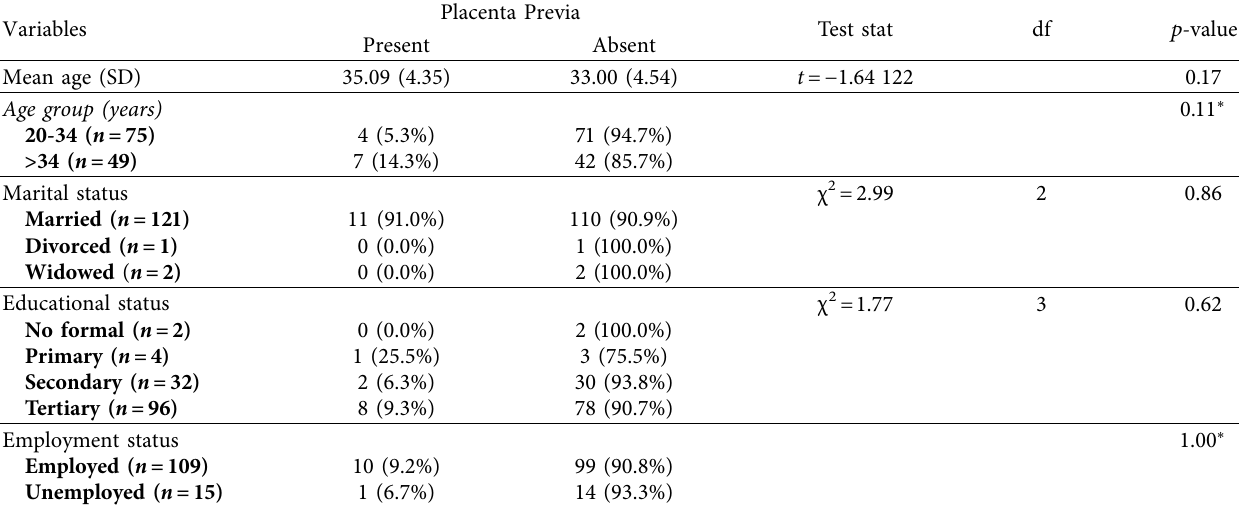
Table 4: The association between sociodemographic factors and the presence of placenta previa using ultrasound among women with a short interpregnancy interval.